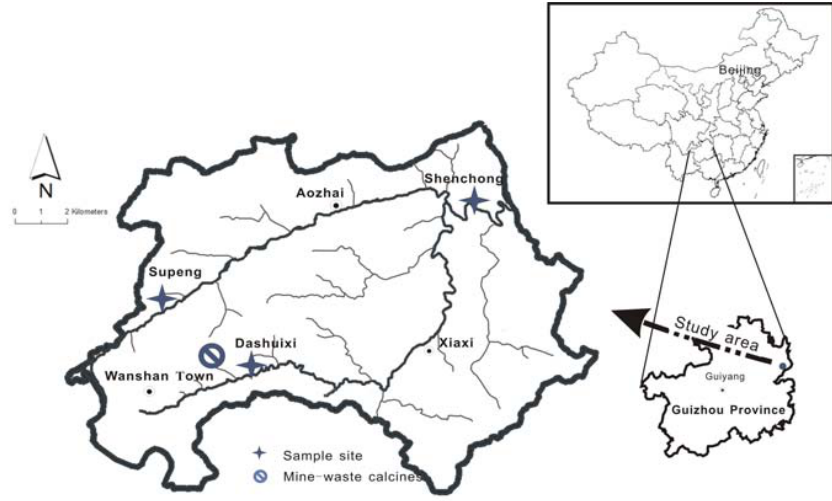
Fig. 1. Map of the study area and sampling